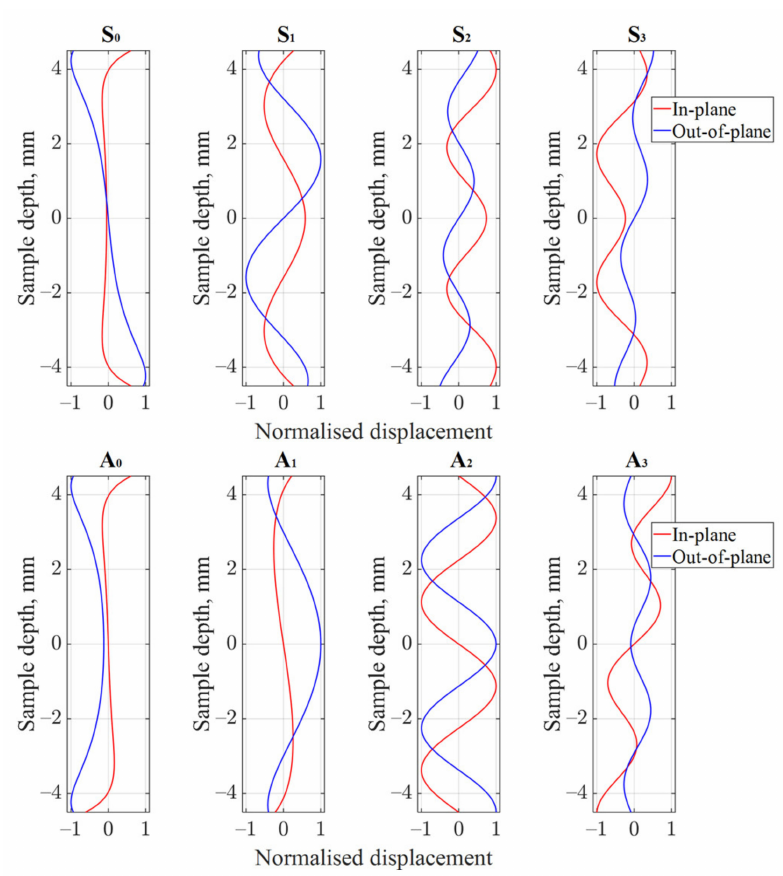
Figure 5. Normalized displacement of wave modes in a 9 mm steel plate at 1 MHz. The title of each figure denotes mode shapes, while indices correspond to mode order.